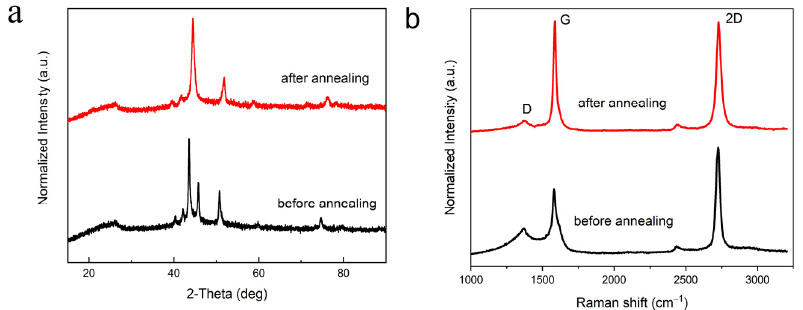
Figure 5. XRD patterns ( a ) and Raman spectra ( b ) of encapsulated nickel particles obtained in toluene before and after annealing.